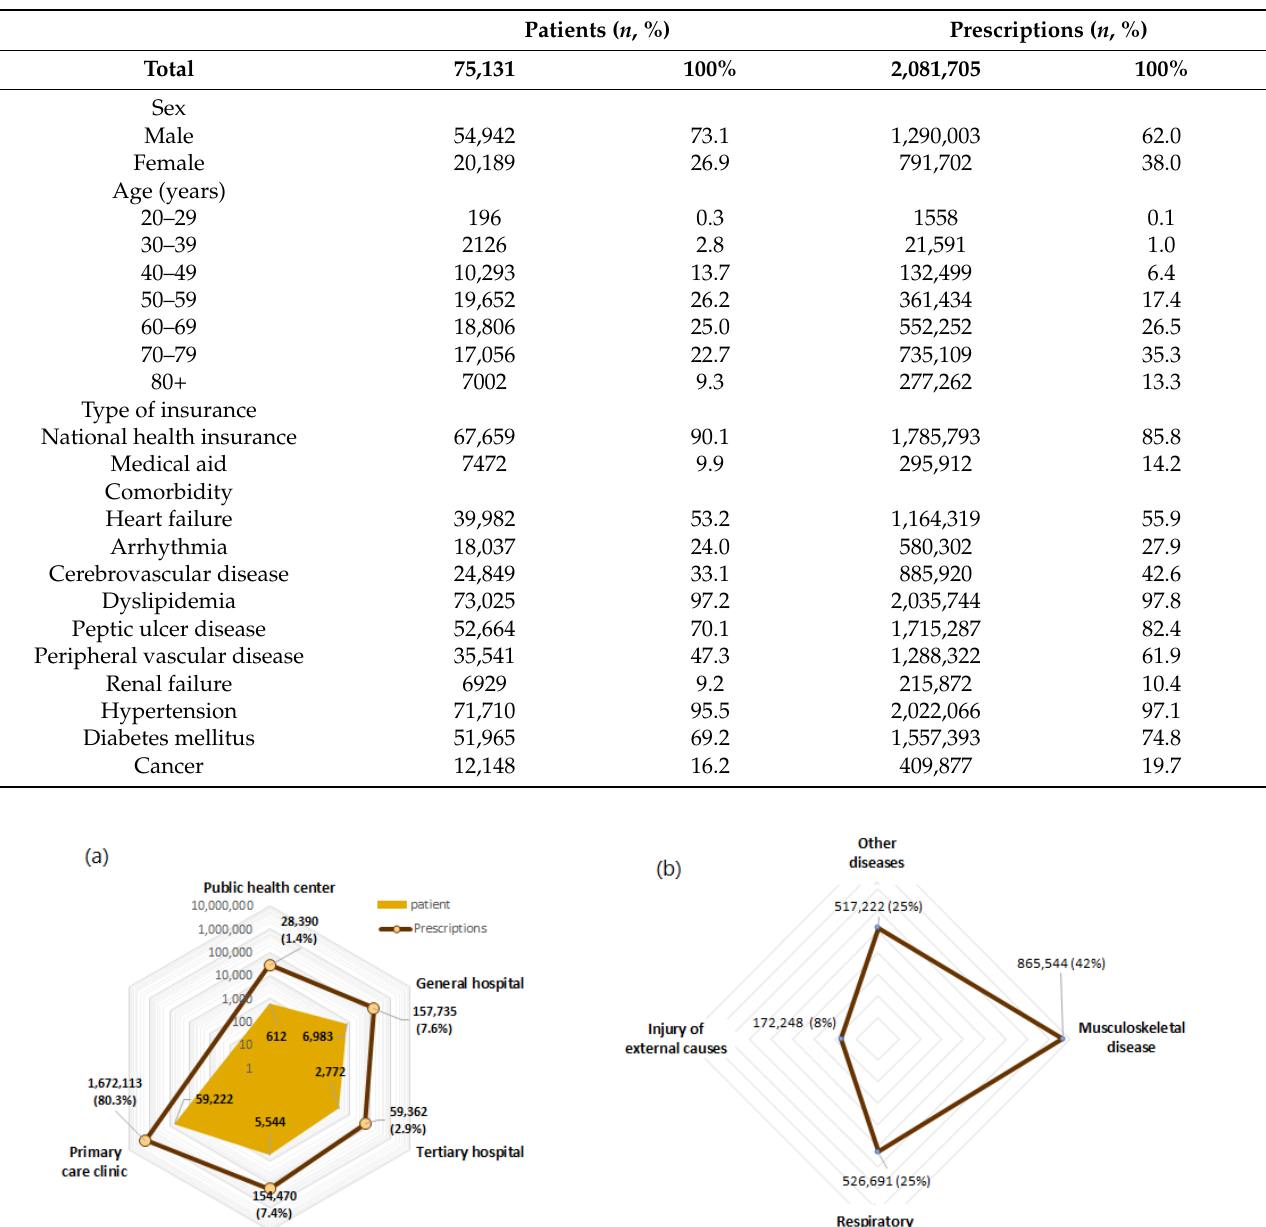
Table 1. General characteristics of prescriptions and patients with analgesic prescriptions who had a history of myocardial infarction between 2008 and 2015.